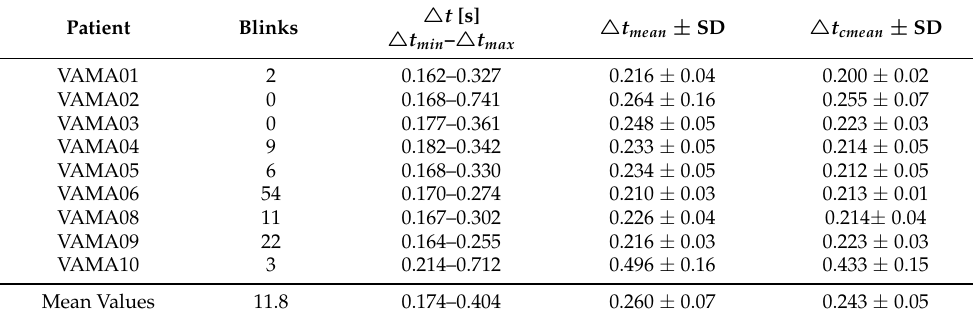
Table 8. Visually guided saccade test: latencies values in post-COVID-19